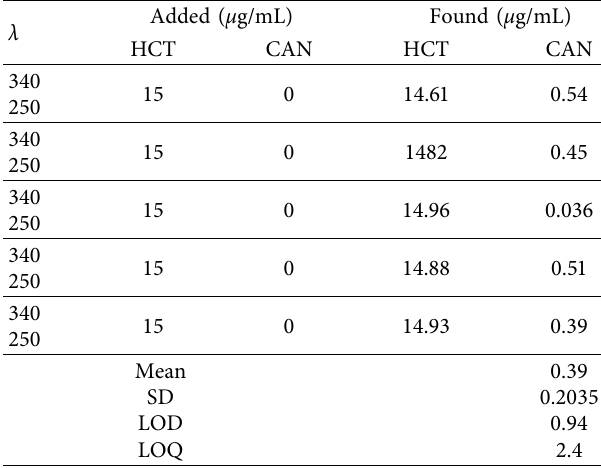
Table 5: Limit of detection (LOD) and limit of quantifcation (LOQ) of CAN by correction